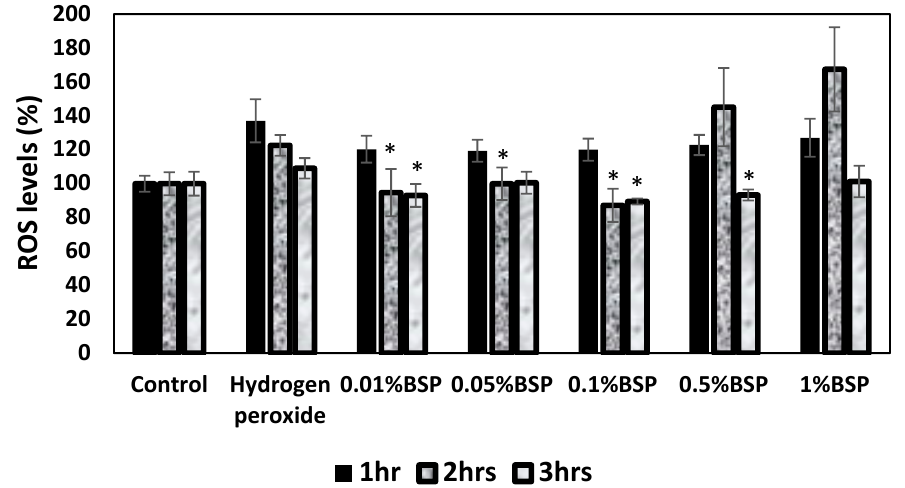
Figure 5. DCFDA cellular R reactive oxygen species (ROS) OS detection assay (n = 6), *p < 0.05 compared to hydrogen peroxide group by one-way ANOVA.